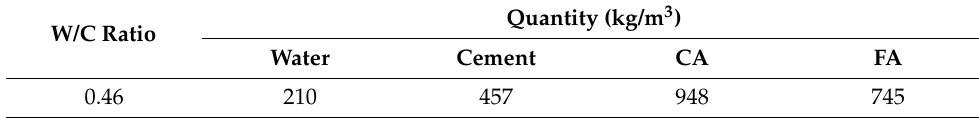
Table 2. Mix proportion of